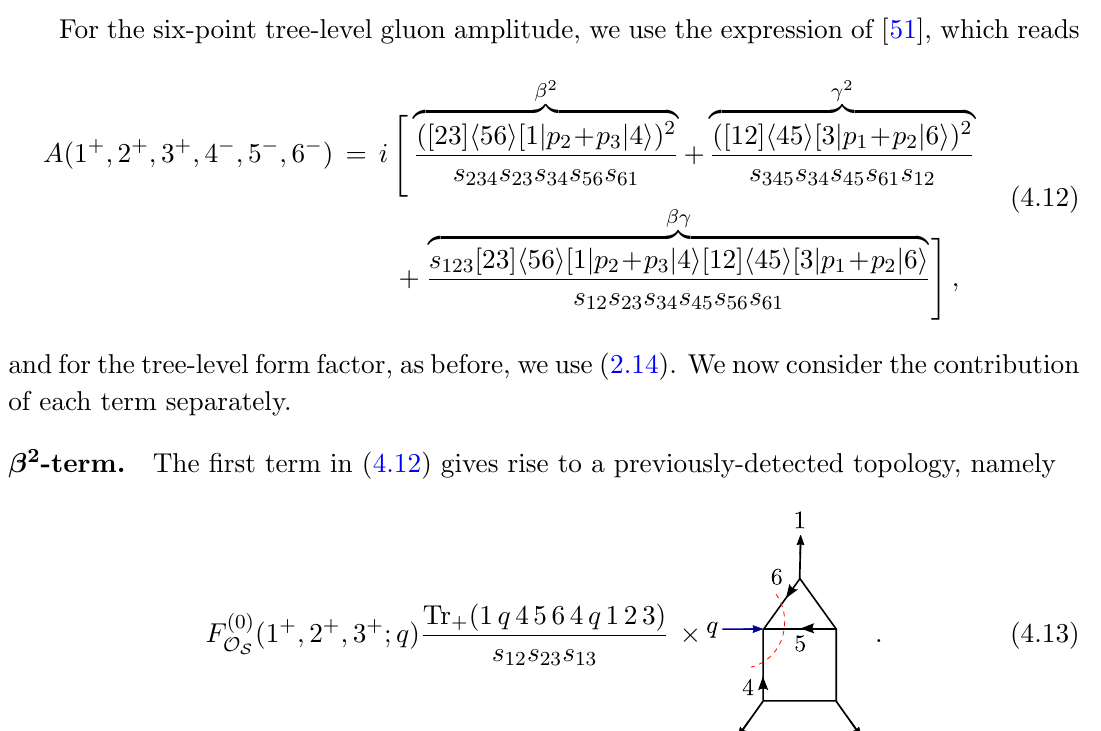
Figure 6 . Triple cut of the two-loop form factor in the q 2 -channel. Only one possible helicity assignment